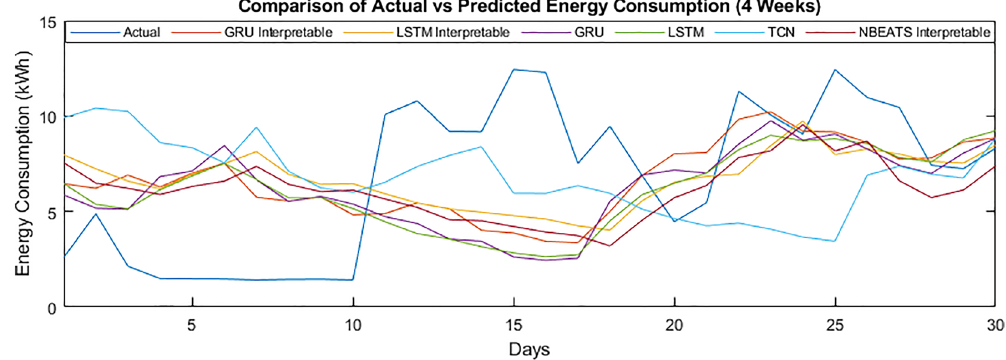
Figure 9. Comparison of actual vs predicted energy consumption (4 weeks).